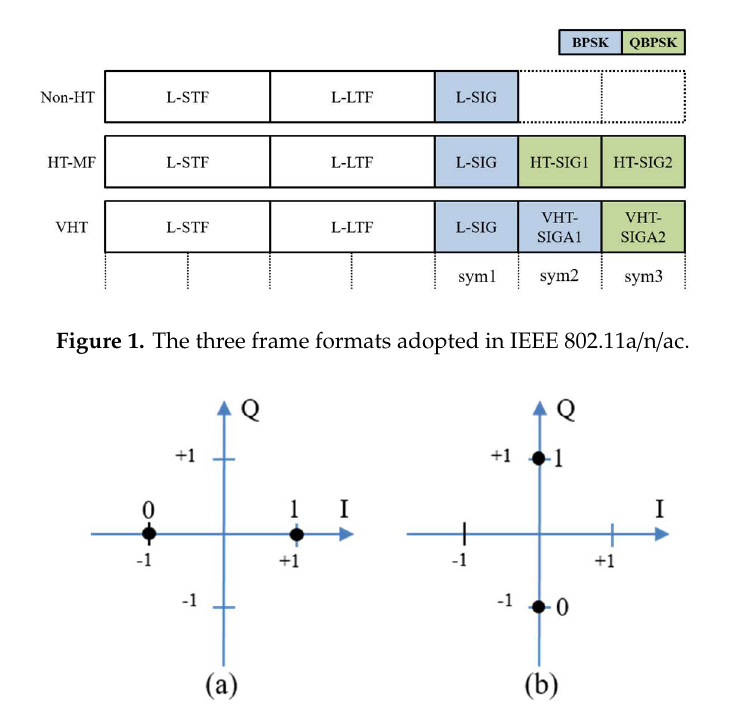
Figure 2. Constellation diagrams of ( a ) binary phase shift keying (BPSK), and ( b ) quadrature BPSK (QBPSK).